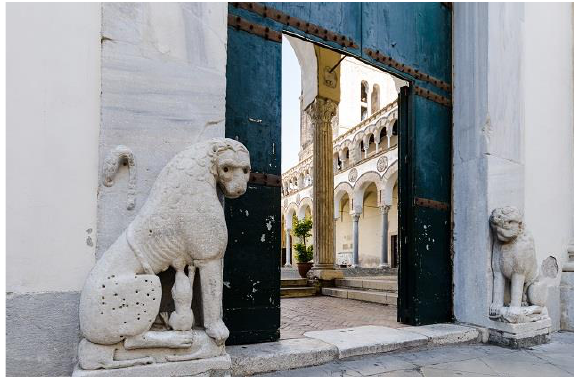
Figure 2. The Porta dei Leoni , Cathedral of San Matteo in Salerno (Italy).